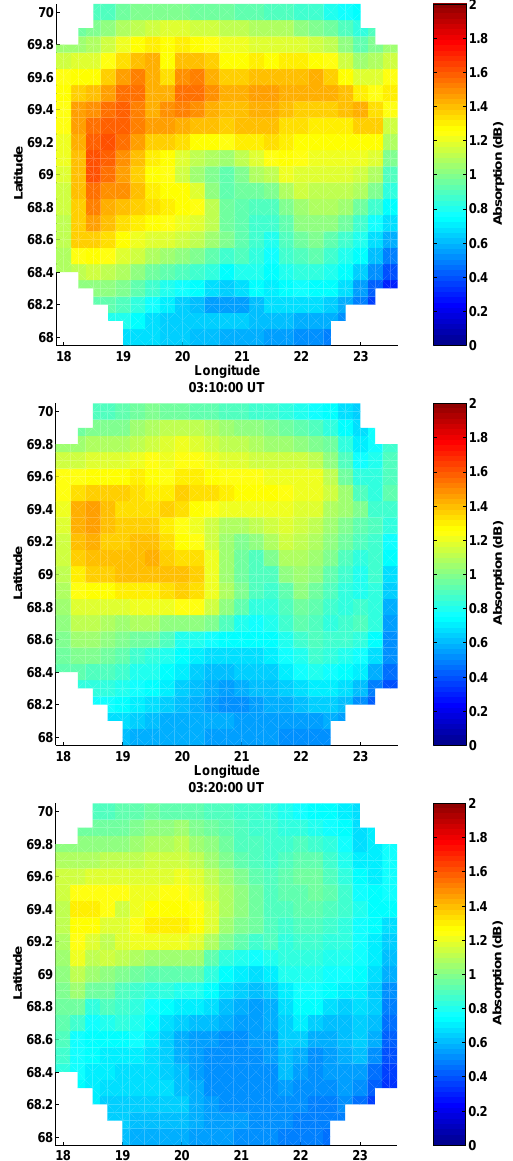
Fig. 9. The background level of absorption during Event 2. These are a series of 10-min means starting at the times shown on each